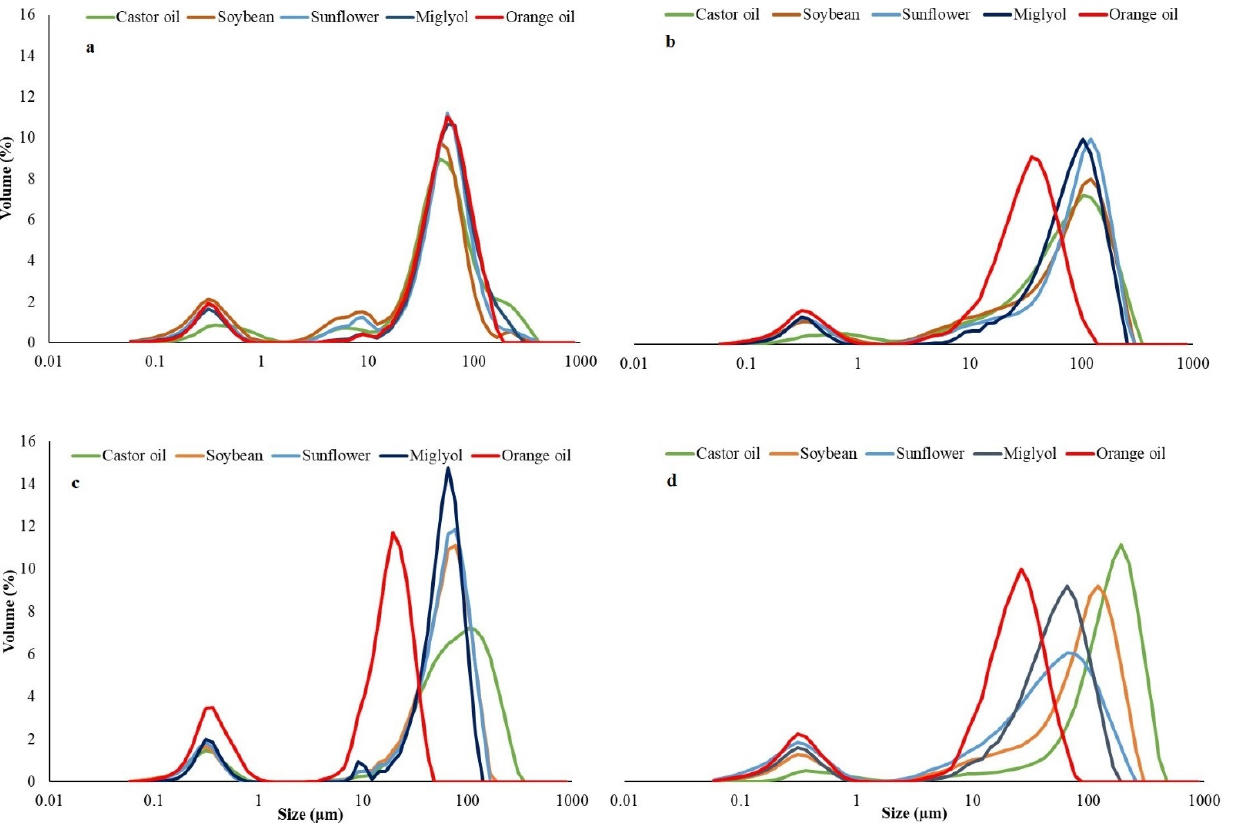
Figure 2. Droplet size distribution in the DE. ( a ) Fresh DEs prepared by DME. ( b ) DEs prepared by DME after 20 days of storage. ( c ) Fresh DEs prepared by MA. ( d ) DEs prepared by MA after 20 days of storage.